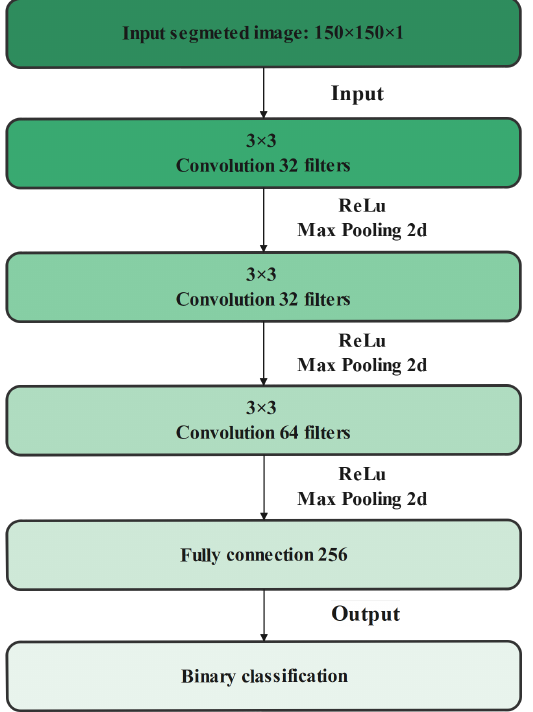
Figure 9. Summary of the proposed CNN